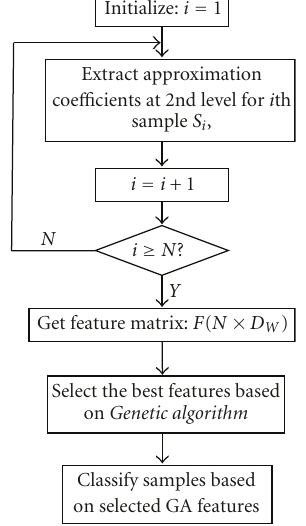
Figure 3: Approximation coe ffi cients at 4 levels.